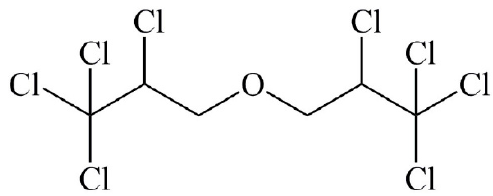
Figure 1. Structure of octachlorodipropyl ether (OCDPE).